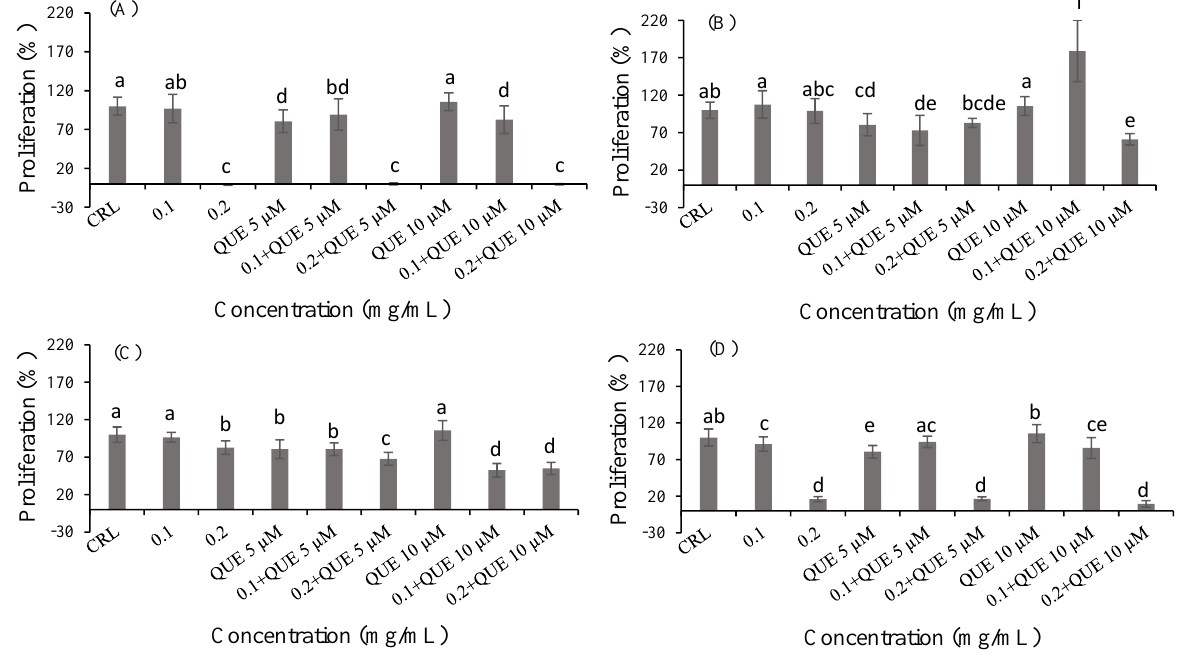
Figure 3. Protective effect of vit E (10 and 25 µM) on the bioaccessible fractions (0.1 and 0.2 mg/mL) of product 1 ( A ), product 2 ( B ), product 3 ( C ) and collagen ( D ) in Caco-2 cells after 24 h of exposure as assessed by the MTT assay. Values are expressed as mean ± SEM ( n = 3). Values in the same figure with different superscript letters are significantly different ( p < 0.05). CRL: control. According to QUE pre-treatment (Figure 4) in product 2 (Figure 4B), an increase in cell proliferation (66.37%) was observed at 0.1 mg/mL of bioaccessible fraction with 10 µM QUE compared to 0.1 mg/mL of bioaccessible fraction alone.